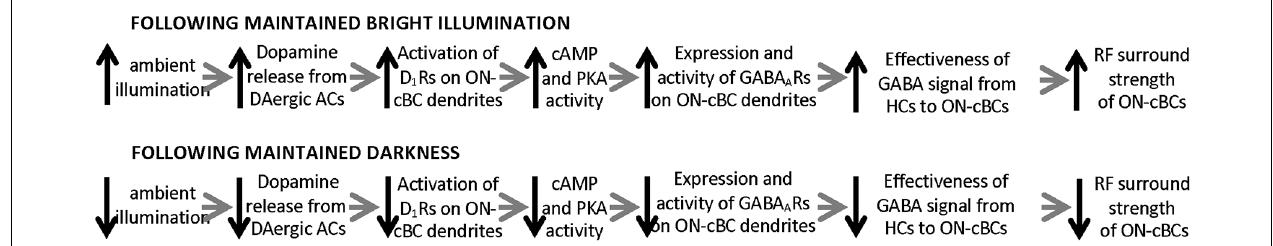
FIGURE 6 | Model of how the ambient light level, by altering dopamine D 1 receptor activation, modulates the GABA A receptor-mediated receptive field surround of ON-cBCs.The model accounts for how changes in ambient (background) light level affect the GABA feedforward signal from HCs to ON-cBC dendrites that mediates the strength of ON-cBC surround responses . As ambient illumination slowly increases during the morning, reaching a peak at midday, D 1 R activation increases, which in turn augments intracellular PKA, so that the expression and activity of GABA A Rs on ON-cBC dendrites-including dendritic tips-are enhanced. As a result, the effectiveness of the GABA A R-mediated feedforward signal from HC dendrites to ON-cBC dendrites increases, enhancing the strength of surround antagonism and activation. Conversely, as background illumination slowly decreases during the afternoon and evening, reaching darkness at night, D 1 R activation is reduced. This in turn decreases intracellular PKA, substantially lowering GABA A R expression and activity so that ON-cBC surround strength is